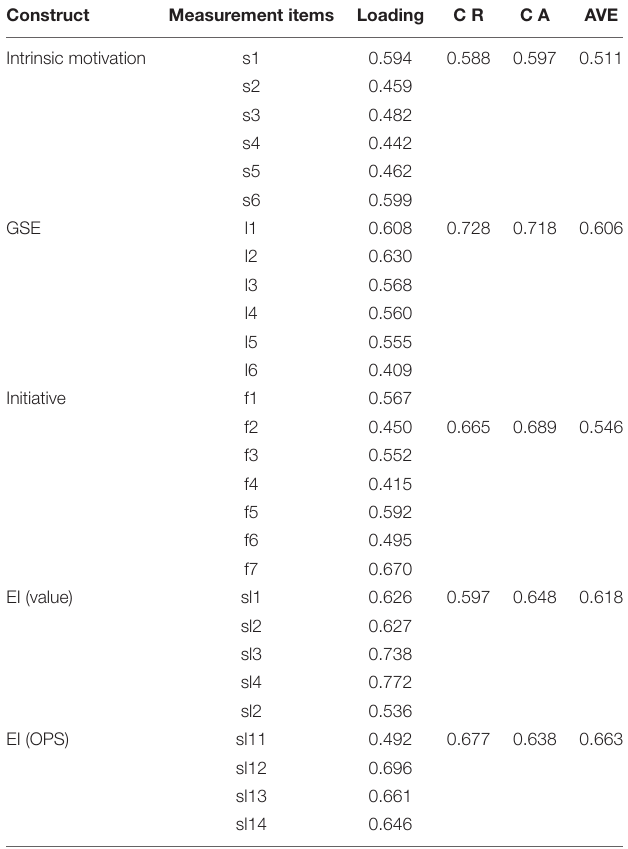
TABLE 1 | Internal consistency reliability and convergent validity.